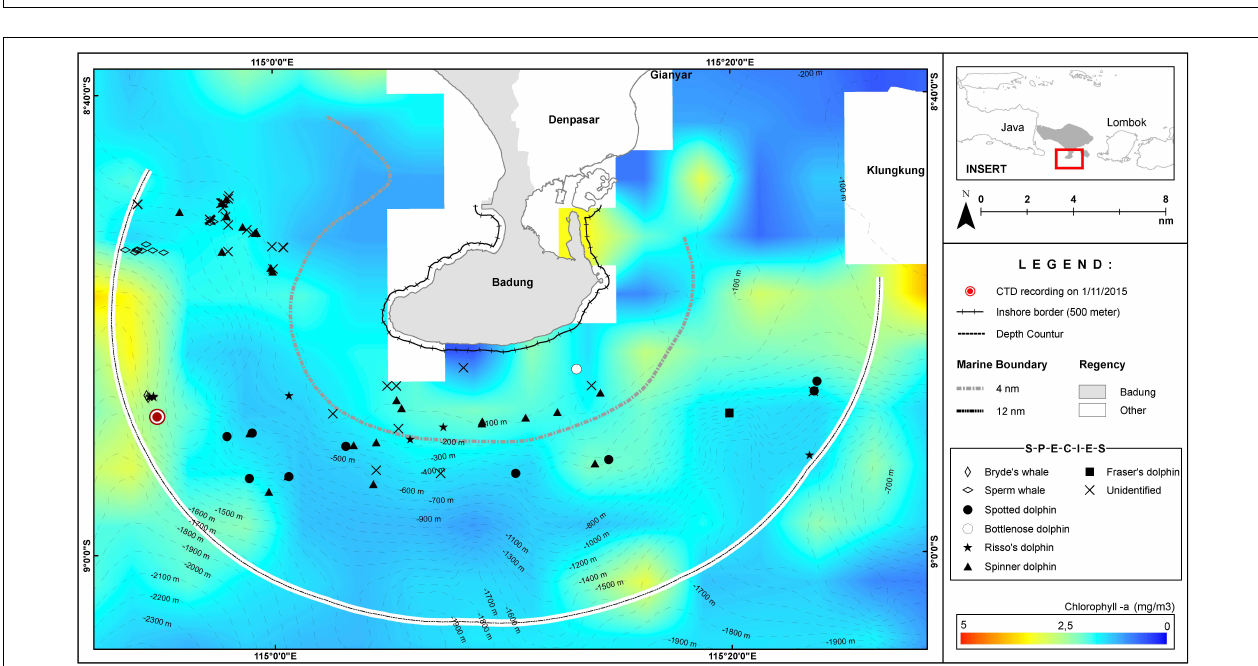
FIGURE 3 | The average chlorophyll-a distribution for November 2015, overlaid with the sightings between 1 and 5 November 2015.